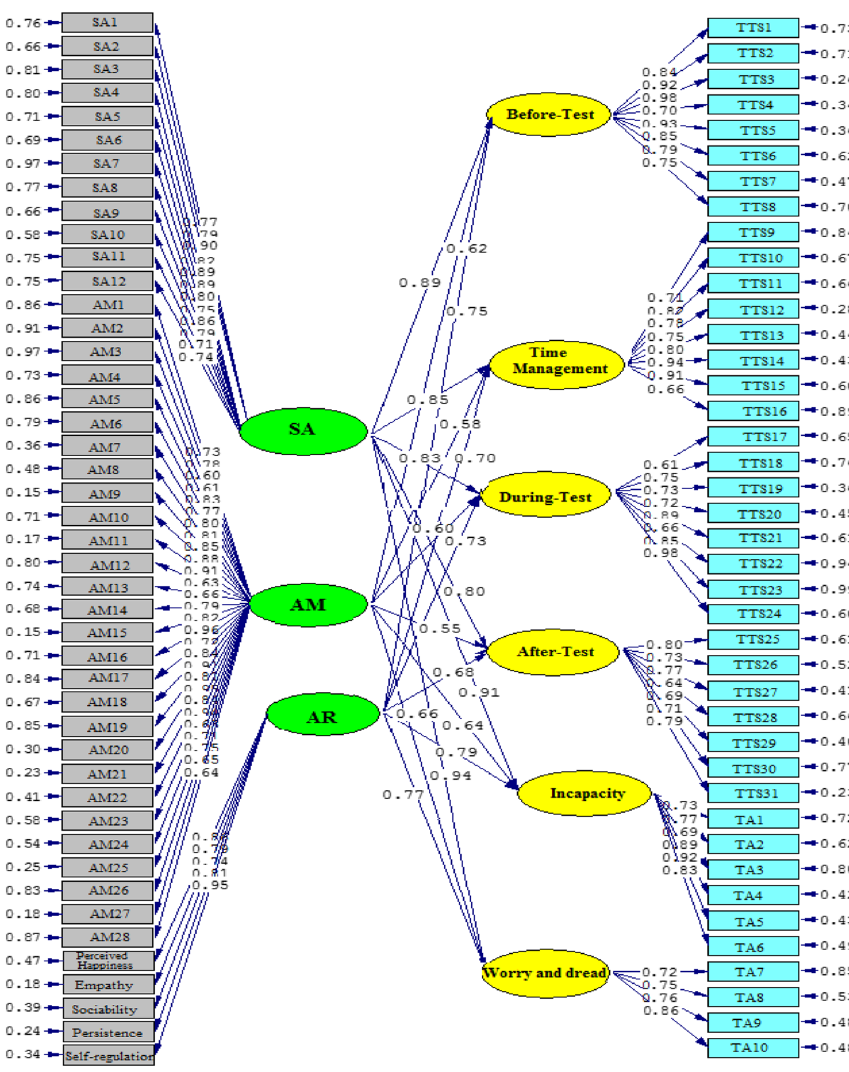
AM, T-TS, and TA subscales (model